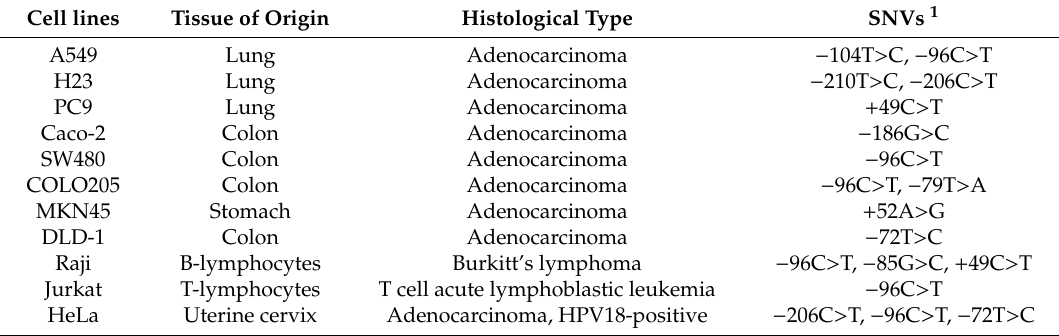
1 SNV, single nucleotide